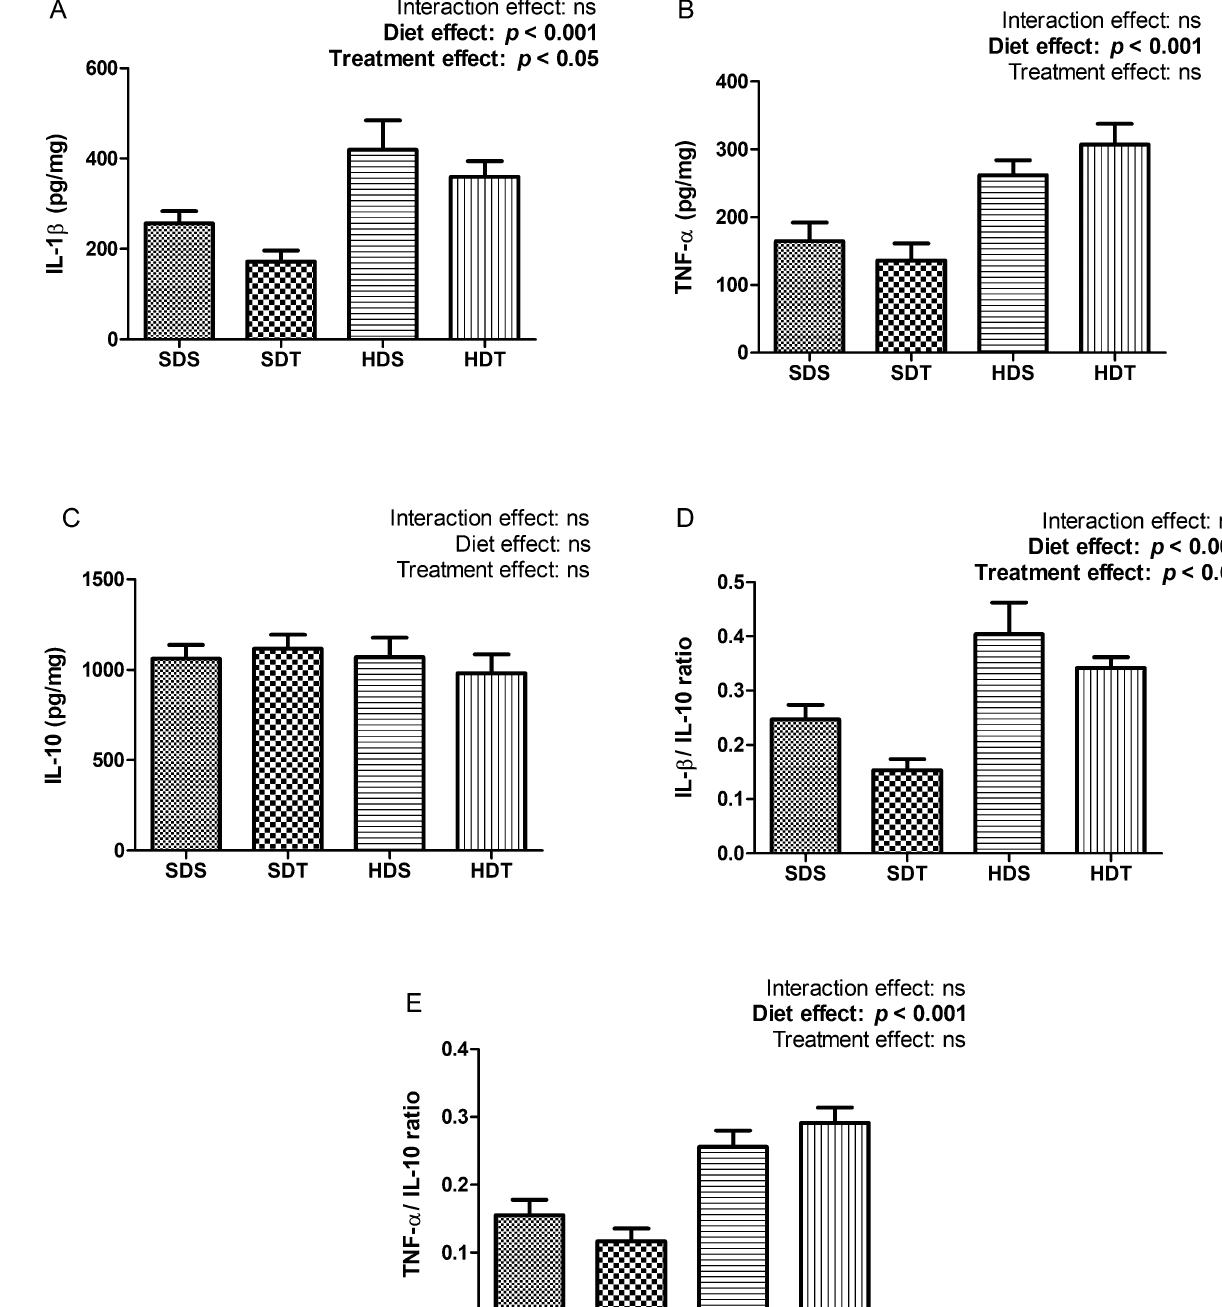
Figure 4. Hepatic inflammatory parameters. ( A ) IL-1β levels, ( B ) TNF-α levels, ( C ) IL-10 levels, ( D ) IL-1β/ IL-10 ratio and ( E ) TNF-α/IL-10 ratio. Data expressed as mean ± SEM (pg/mg of protein), (n = 10/group).